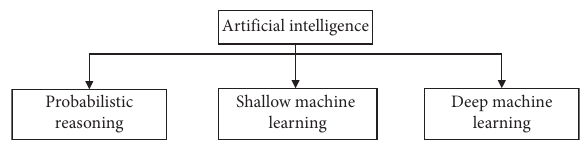
Figure 3: Branches of artificial intelligence in this